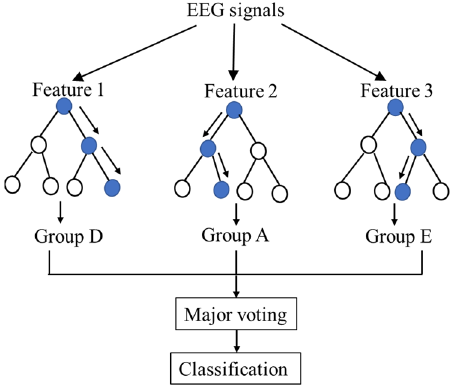
Figure 4. Schematic procedures of the RF classifier.